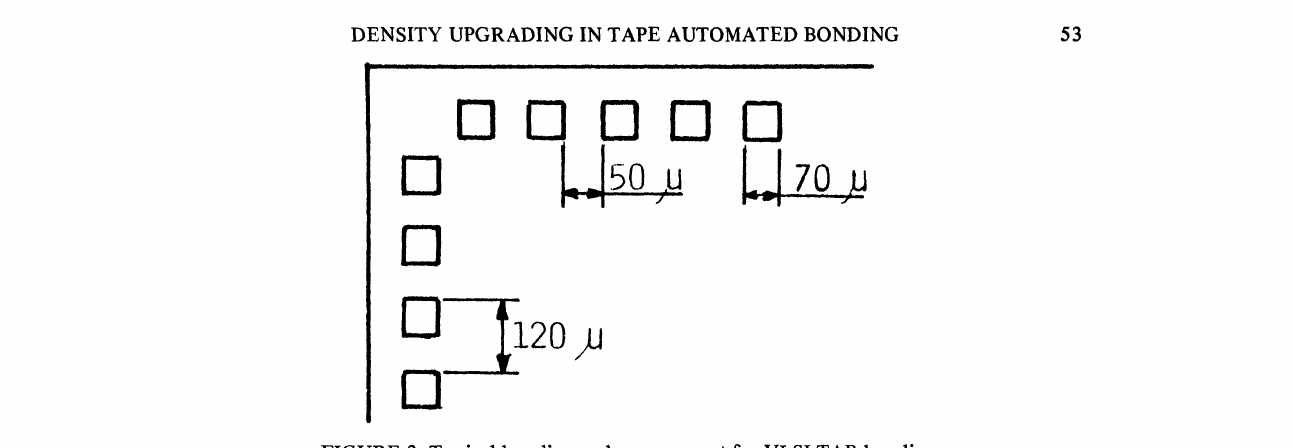
FIGURE 3 Typical bonding pad arrangement for VLSI TAB bonding.